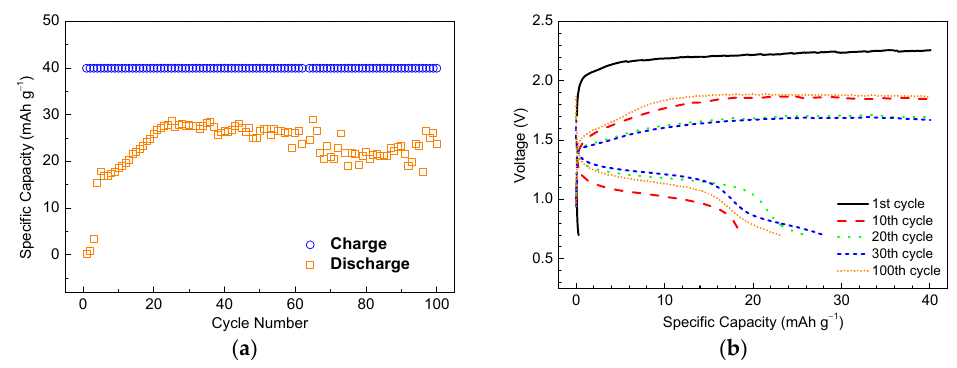
Figure 4. ( a ) Specific capacities as a function of cycle number and ( b ) charge/discharge characteristics at different cycles for a Ni/MH half-cell using 2 M acetic acid/[EMIM][Ac]. Anode: AB5 MH alloy.